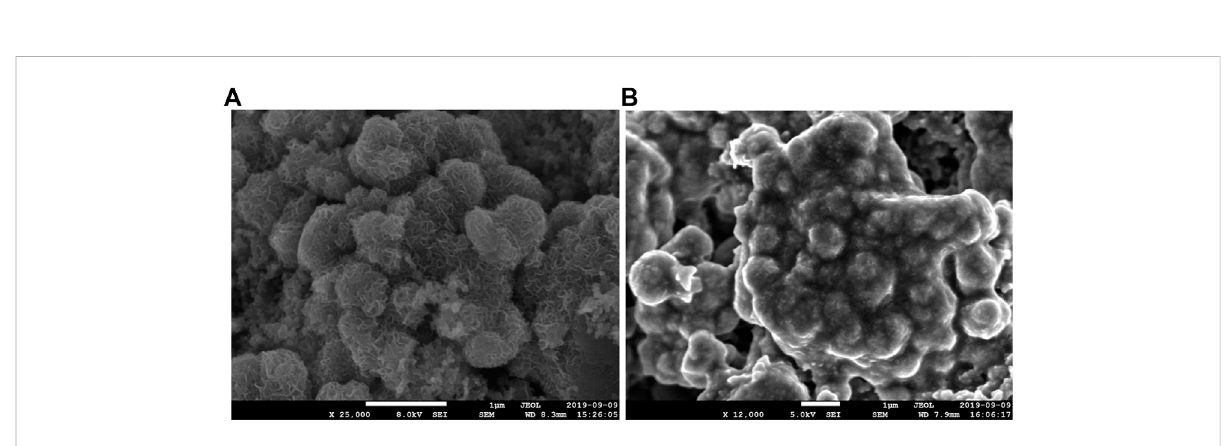
FIGURE 5 SEM images of GO/MoS 2 -based electrodes before (A) and after 100 times, galvanostatically cycled at 100 mA/g (B)